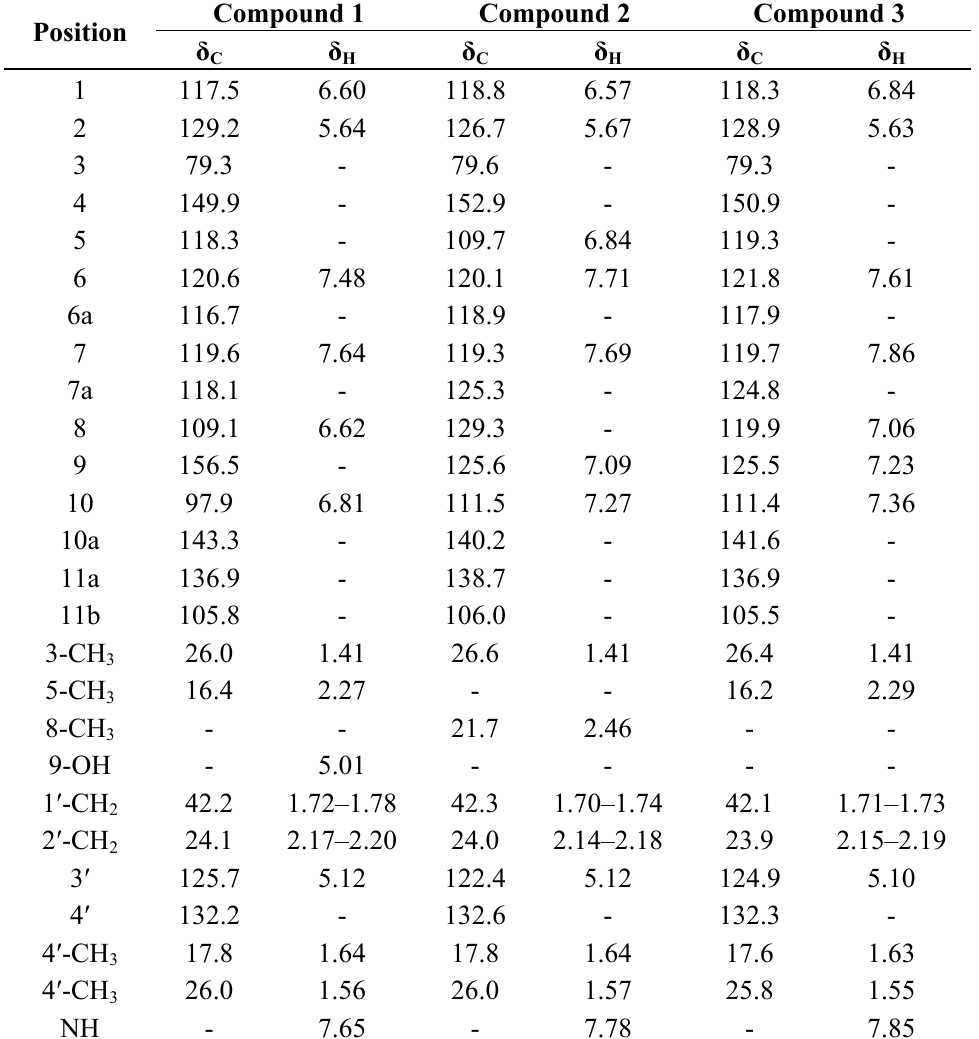
Table 1. 1 H-NMR and 13 C-NMR spectral data of the isolated compounds from leaves